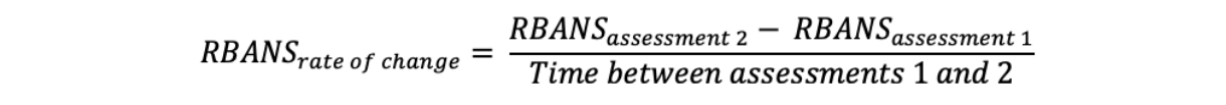
The data set initially contained 525 variables.